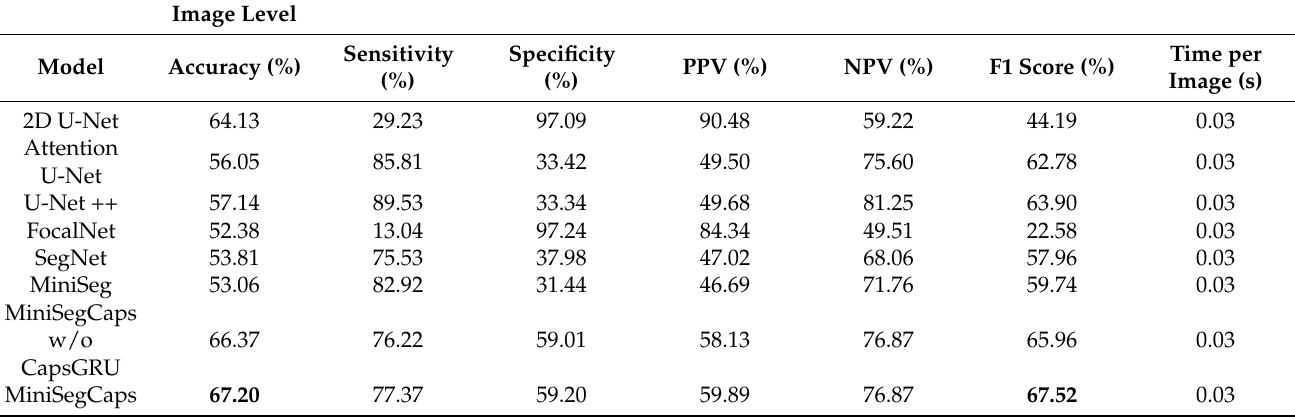
Table 5. Comparison of the image-level performance between our method and baseline methods in prostate cancer classification on PI-RADS ≥ 3.